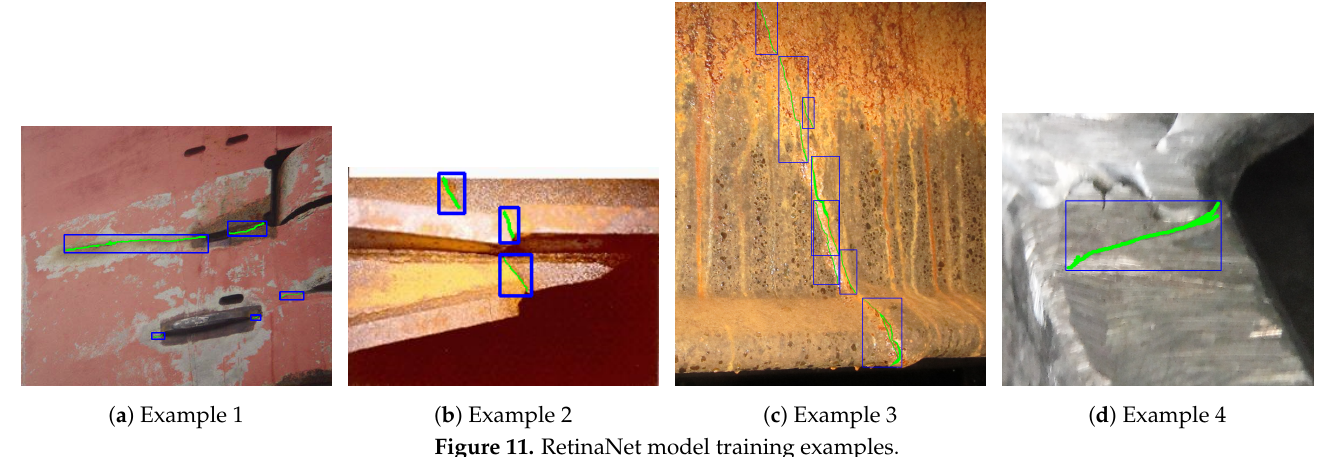
Figure 11. RetinaNet model training